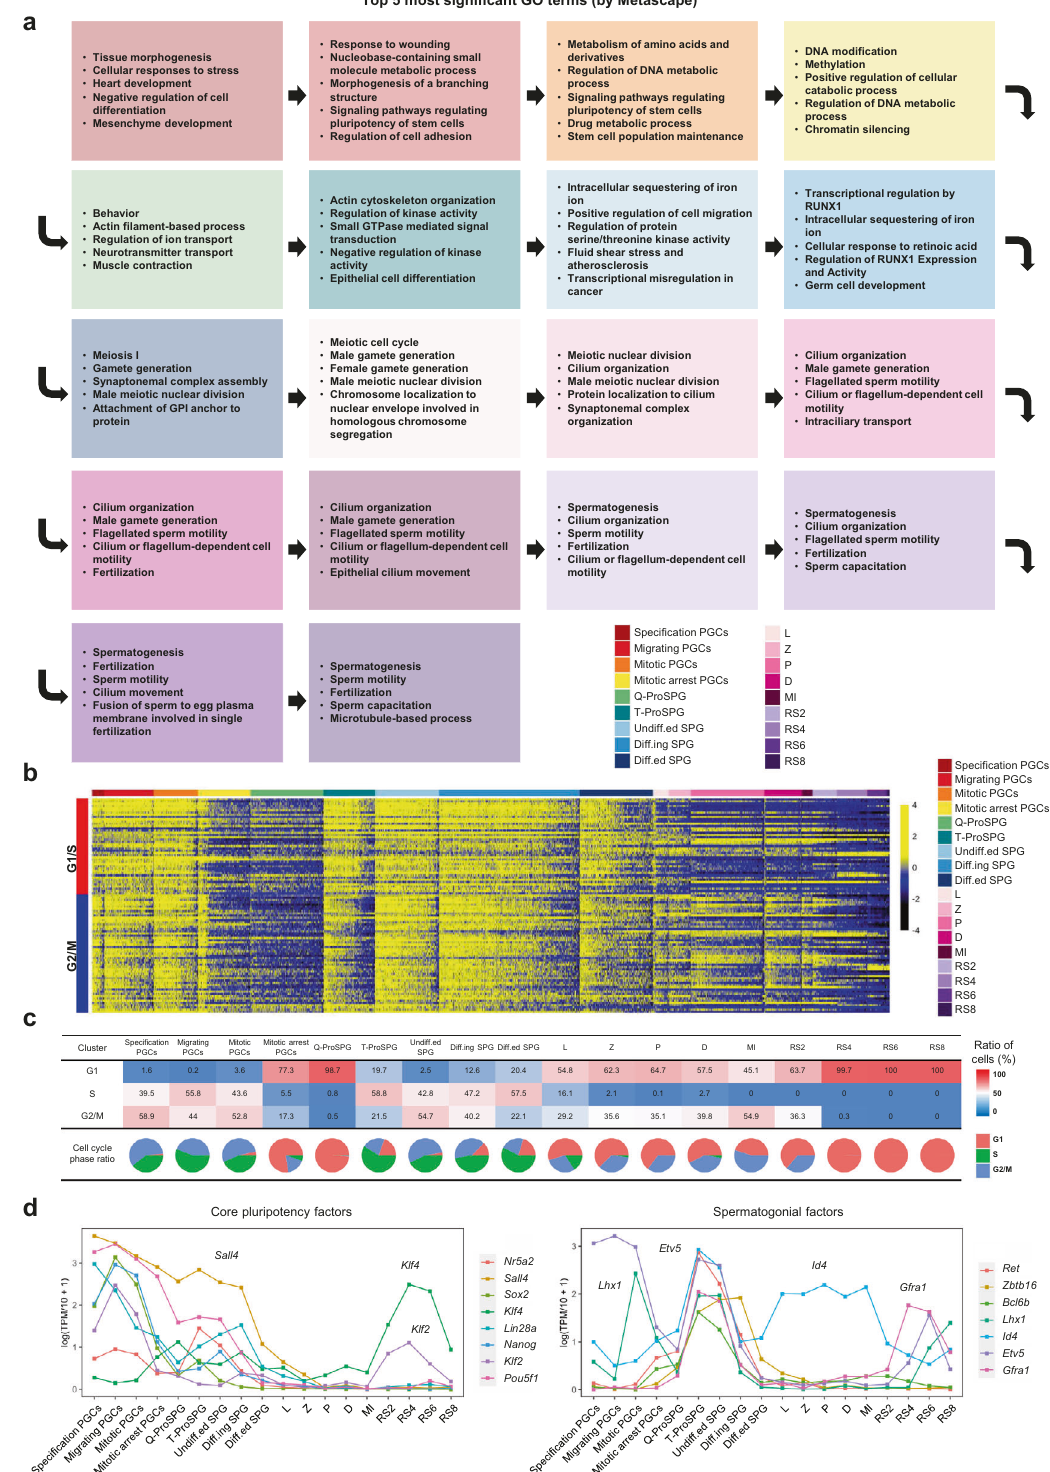
Fig. 2 Transcriptome signatures of mouse male germ cells. a Top 5 most signi fi cant GO terms and P values (-LogP) of 18 germ cell clusters are indicated by distinct colors, respectively. b Heatmap of 97 cell-cycle-related genes in mouse male germ cells. The color key from black to yellow indicates low to high expression levels. L, leptotene; Z, zygotene; P, pachytene; D, diplotene; MI, metaphase I; RS, round spermatids. c Proportion germ cells in one of three cell- cycle phase. d Line plots showing the relative expression levels (log(TPM/10 + 1)) of previously known core pluripotency factors, and spermatogonial factors in each cell